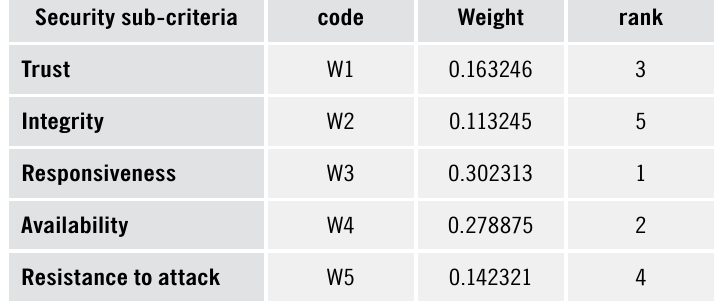
Table 8. Weight of security sub-criteria in reliability (taken from the fuzzy nonlinear model) Security sub-criteria